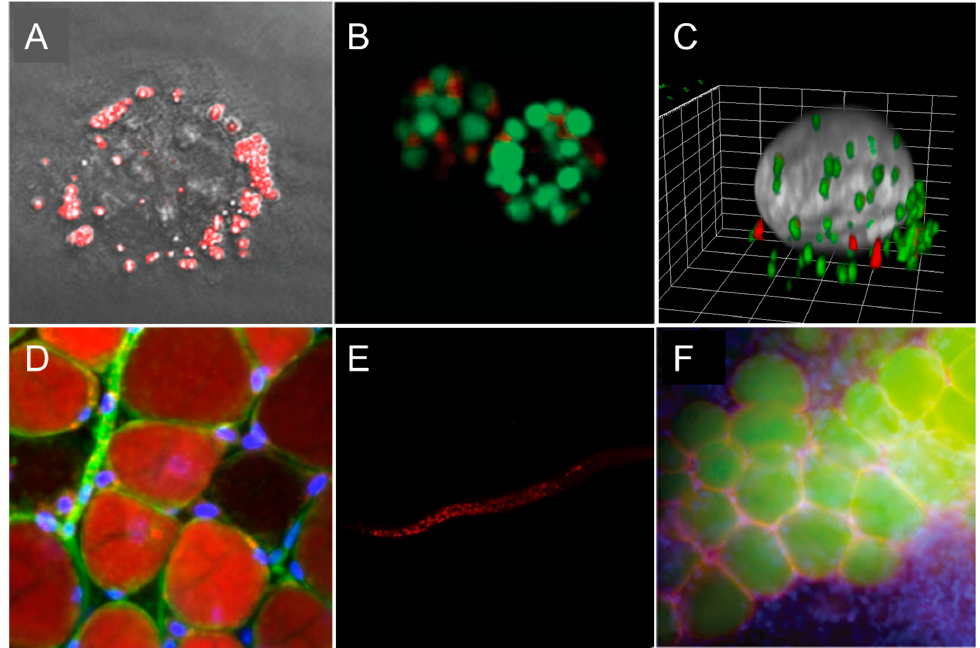
Figure 7. Representative fluorescence microscopy images of LDs. ( A ) Two-photon excited fluorescence image of LDs labeled with IND-TPA in HCC827 cells [47]. ( B ) LDs of green algae stained by SF44 (in green); fluorescence from chlorophyll (in red) [44]. ( C ) Three-dimensional (3D) view of a KB (HeLa derivative) cell displaying exchanged LDs from another cell (SMCy 3.5 in green and SMCy 5.5 in red) [23]. ( D ) Image of adipocytes in mouse adipose tissue (25 µm depth) obtained by a maximum projection of a Z-stack (100 slices of 250-nm depth each). LDs were stained with SMCy 3.5 (in red), nuclei in blue, and plasma membrane in green [23]. ( E ) Images of LDs stained with BTD-Lip (in red) in C. elegans (worm) [46]. ( F ) LDs imaging with LipidGreen (in green) in vertebral adipose tissues of zebrafish (nucleus in blue, LD-associated protein in red) [32]. Images ( A , B , F ) were reproduced with permission from The Royal Society of Chemistry. Images ( C , D , E ) were reproduced with permission from the American Chemical Society.